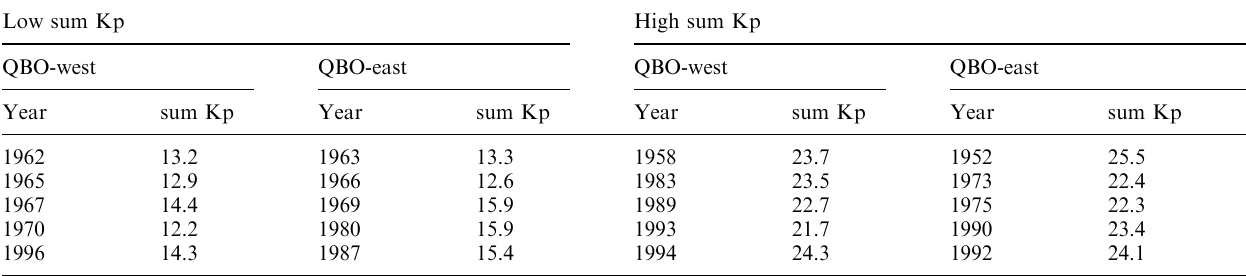
Table 2. Winter periods used for the composite maps calculations Low sum